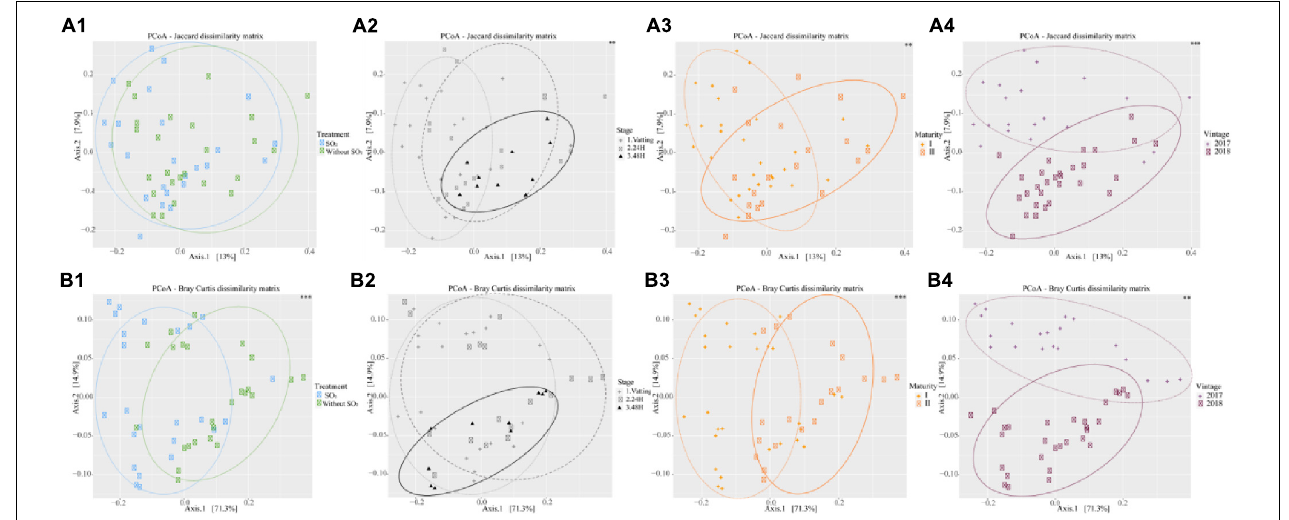
FIGURE 5 | β – diversity by two matrix [Jaccard (A) and Bray Curtis (B) ] in function of SO 2 addition or not (1), Stage (Vatting, 24H and 48H of maceration,except 48 h maceration in 2017) (2), maturity (3) [technological (I) and advanced maturities (II)] and vintage (4) (2017 and 2018). Signif. codes for p -value (Manova): ∗∗∗ 0.001, ∗∗